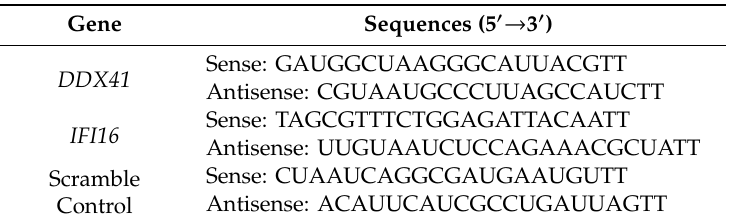
Table 2. The siRNA sequences.